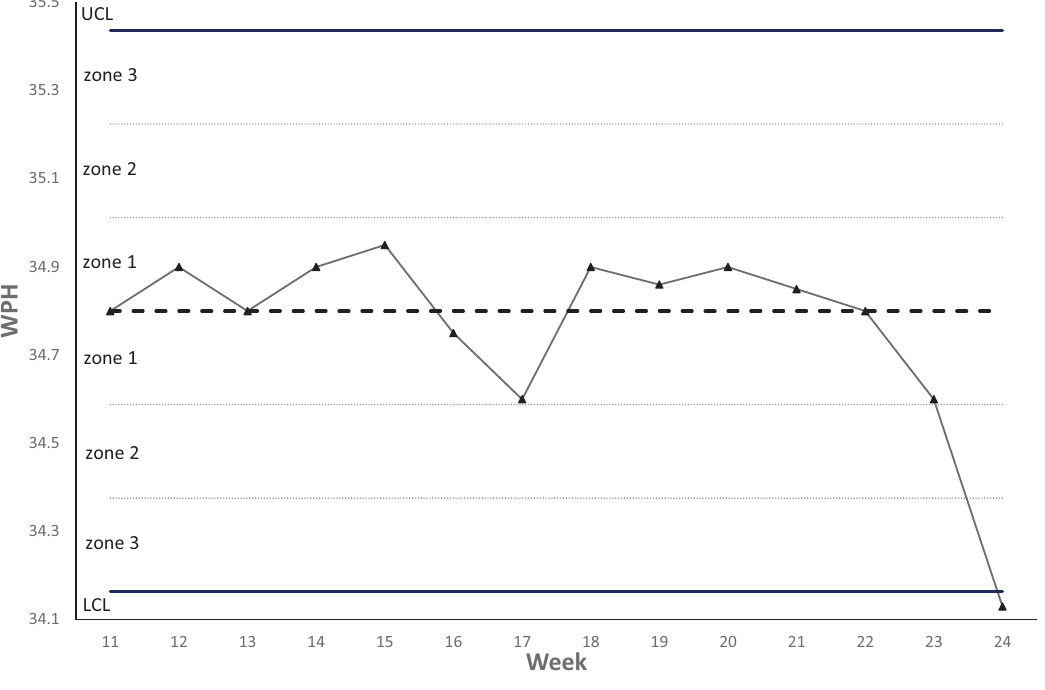
Figure 10. Throughput control chart for average WPH. Table 1. Basic tests for identifying special-cause variation or potential